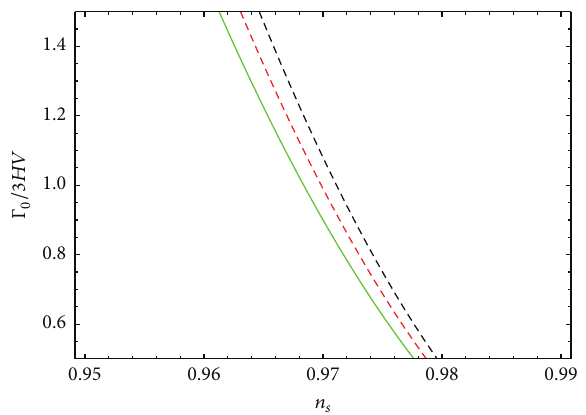
Figure 4: In this graph we plot the dissipative to Hubble parameter ratio Γ 0 /3𝐻𝑉 in terms of the spectral index 𝑛 𝑠 . We can find best fit of high dissipative regime Γ 0 > 3𝐻𝑉 with the Planck data for three cases of Γ 0